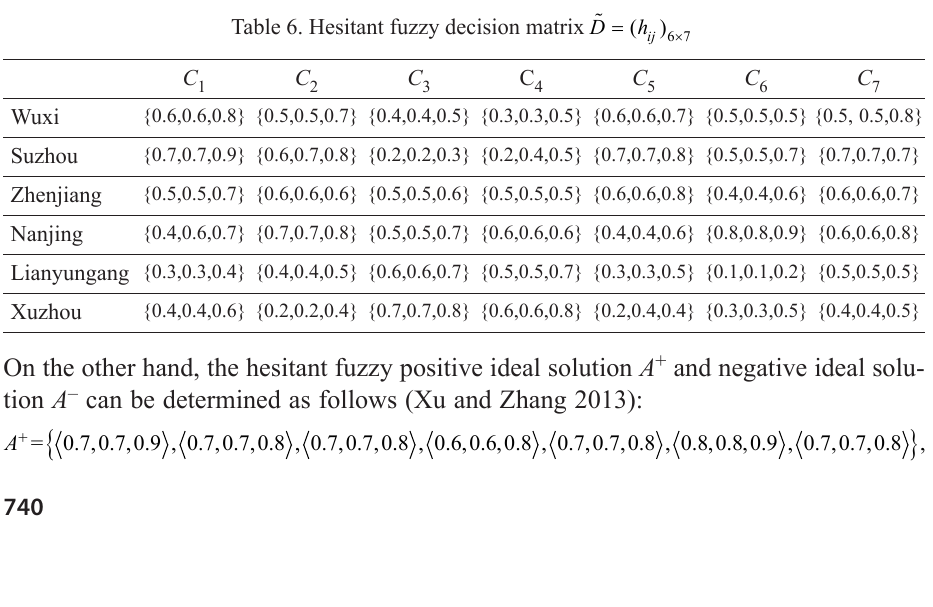
Table 5. Results obtained by generalized hesitant fuzzy distance d Y Y Y 1 2 3